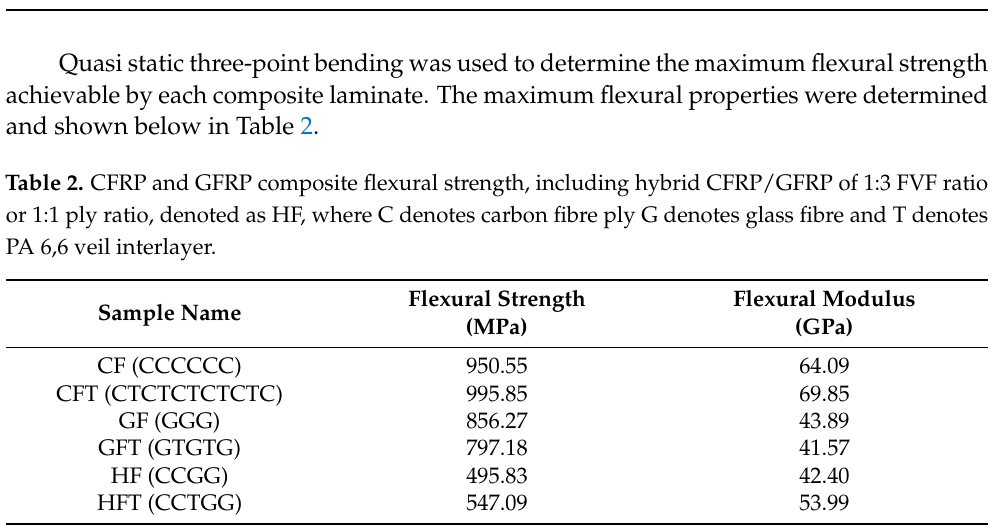
Table 4. load case and number of cycles .